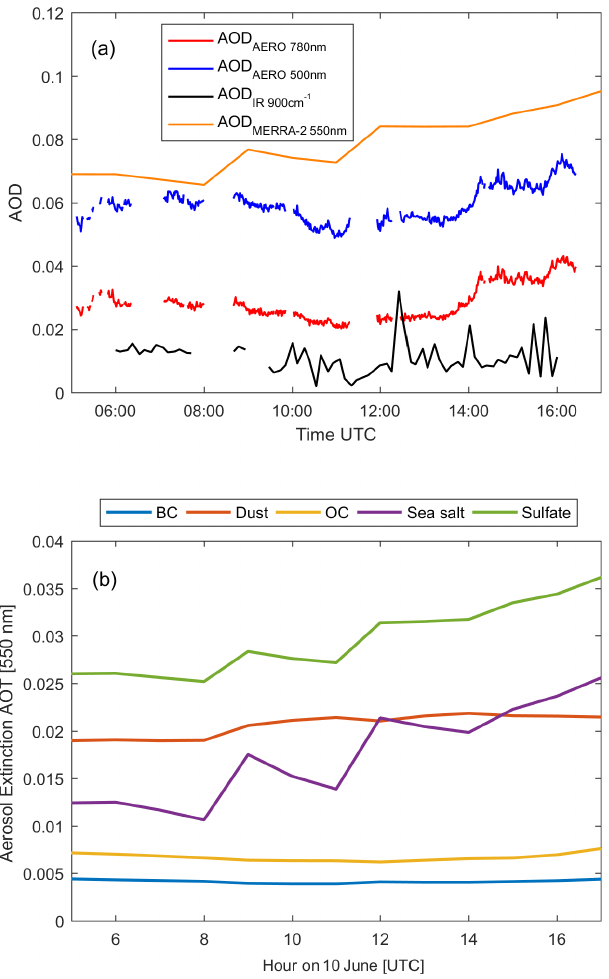
Figure 8. (a) AOD measured by a Sun photometer (AERONET, 500nm in blue and 780nm in red), AOD measured by the FTS (900cm − 1 in black), and AOD from MERRA-2 reanalysis data (550nm) in Ny-Ålesund on 10 June 2020. (b) The AOD of dif- ferent aerosol components in MERRA-2 reanalysis data in Ny- Ålesund on 10 June 2020. AERONET data are from https://www. mdpi.com/2072-4292/11/11/1362 (last access: 6 December 2022), and MERRA-2 data are from https://goldsmr4.gesdisc.eosdis.nasa. gov/data/MERRA2/M2T1NXAER.5.12.4/ (last access: 6 Decem- ber 2022).